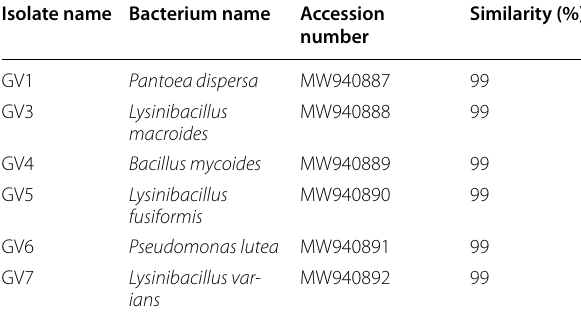
Table 3. 16S results of bacteria Isolate name Bacterium